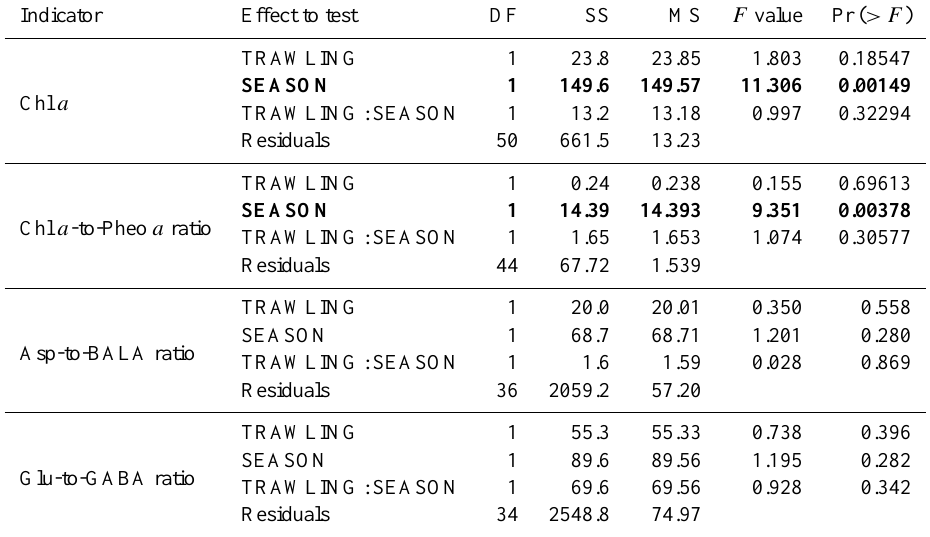
DF: degrees of freedom; SS: sum of squares; MS: mean squares, obtained dividing the sum of squares by the degrees of freedom; F represents the result of the F test and is obtained dividing the mean squares of the inter-group variability by the mean squares of the intra-group variability.